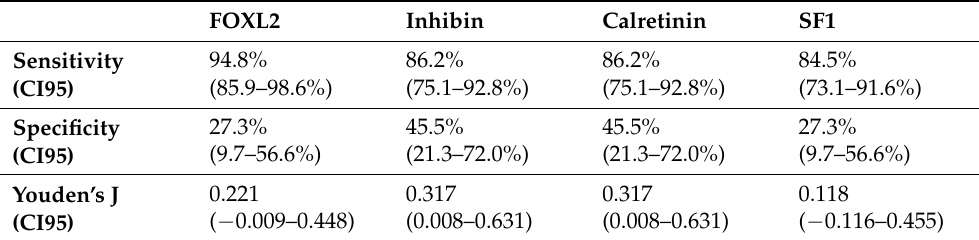
Table 2. Performance of IHC markers to predict FOXL2 p.C134W or FOXL2 wild-type status in tumors diagnosed as GCTs/likely